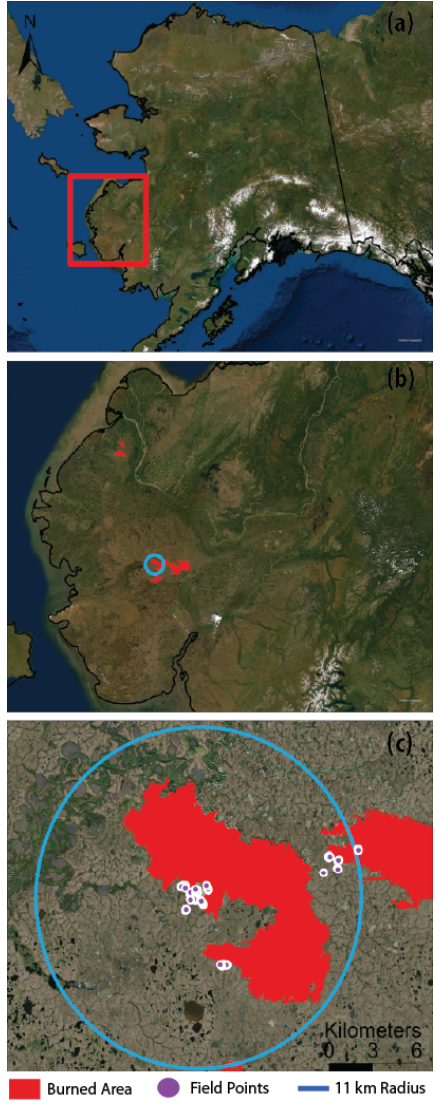
Figure 1. (a) The location of the YKD within Alaska, (b) the areas of fires in 2015 within the YKD, and (c) the locations of our vege- tative reference-point height transects in burned and unburned areas within about an 11km radius from the base camp. Fire perimeters were derived from the Alaska Large Fire Database (Kasischke et al., 2002). Sources: Esri, DigitalGlobe, GeoEye, i-cubed, USDA FSA, USGS, AEX, Getmapping, Aerogrid, IGN, IGP, swisstopo, and the GIS user community.